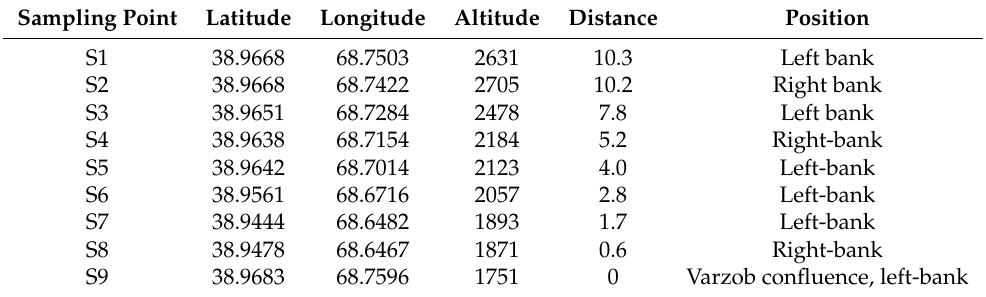
Table A1. Coordinates of sampling points , altitude above sea level (m) and distance to confluence